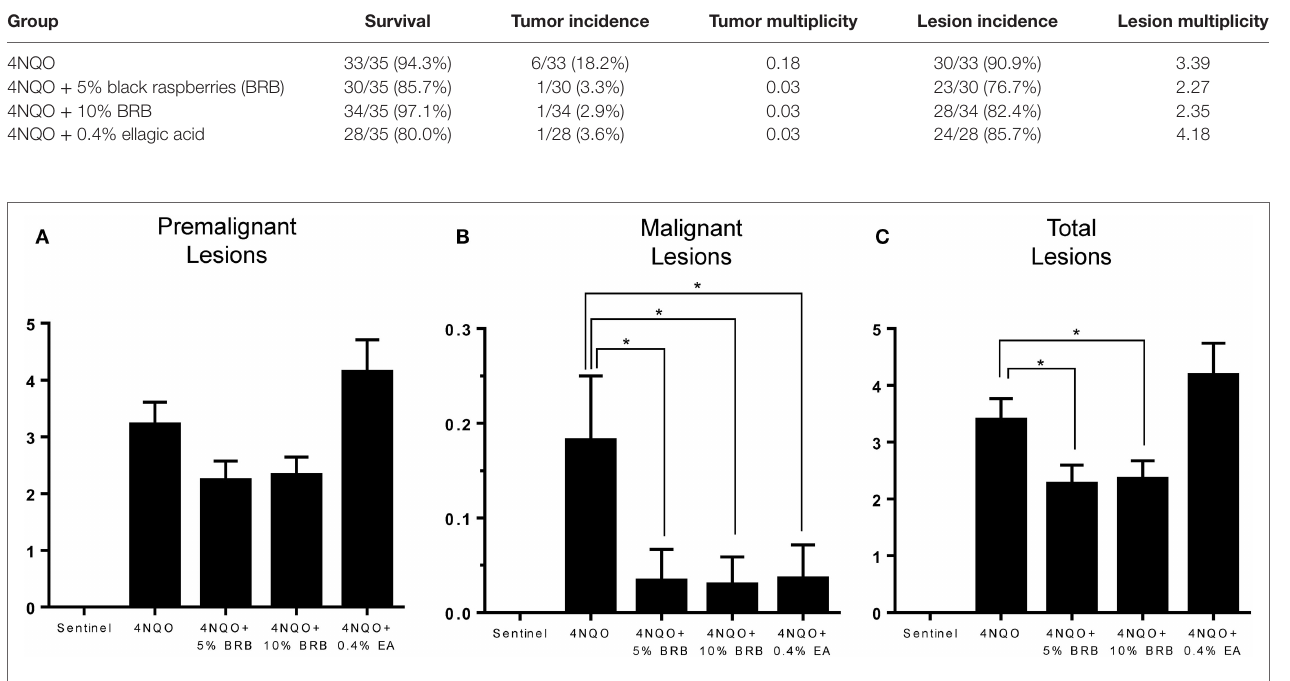
FigUre 2 | (a–c) Average number of (a) premalignant, (B) malignant, and (c) total lesions in 4-nitroquinoline 1-oxide (4NQO)-induced rat tongues fed control diet (4NQO group) or diet supplemented with 5% black raspberry (BRB) (4NQO + 5% BRB group), 10% BRB (4NQO + 10% BRB group), or 0.4% ellagic acid (EA) (4NQO + 0.4% EA group). Data are expressed as mean ± SE of all rats in the group. * p -value < 0.05 for group comparisons using independent Student’s t -test.